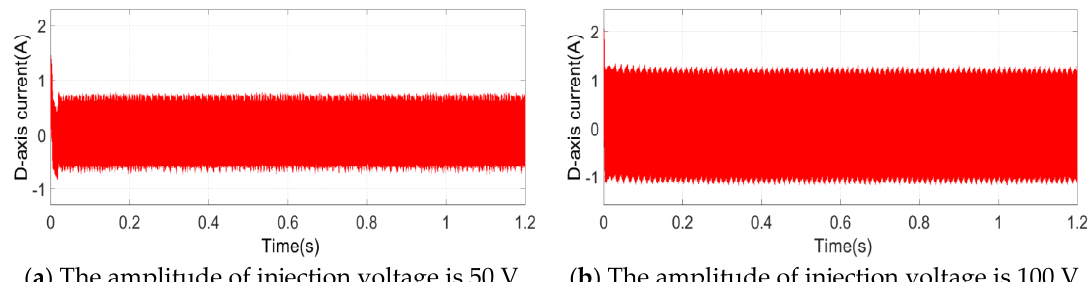
Figure 14. The d -axis current at di ff erent amplitudes of injection